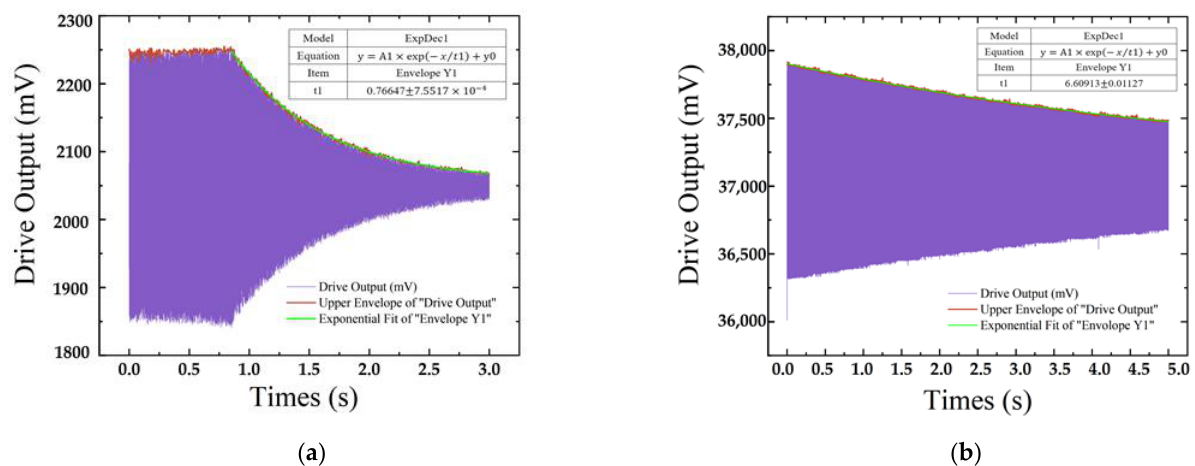
Figure 9. The time domain dynamic response measured at the drive mode of the gyroscope: ( a ) ceramic shell package; ( b ) novel 3D package.